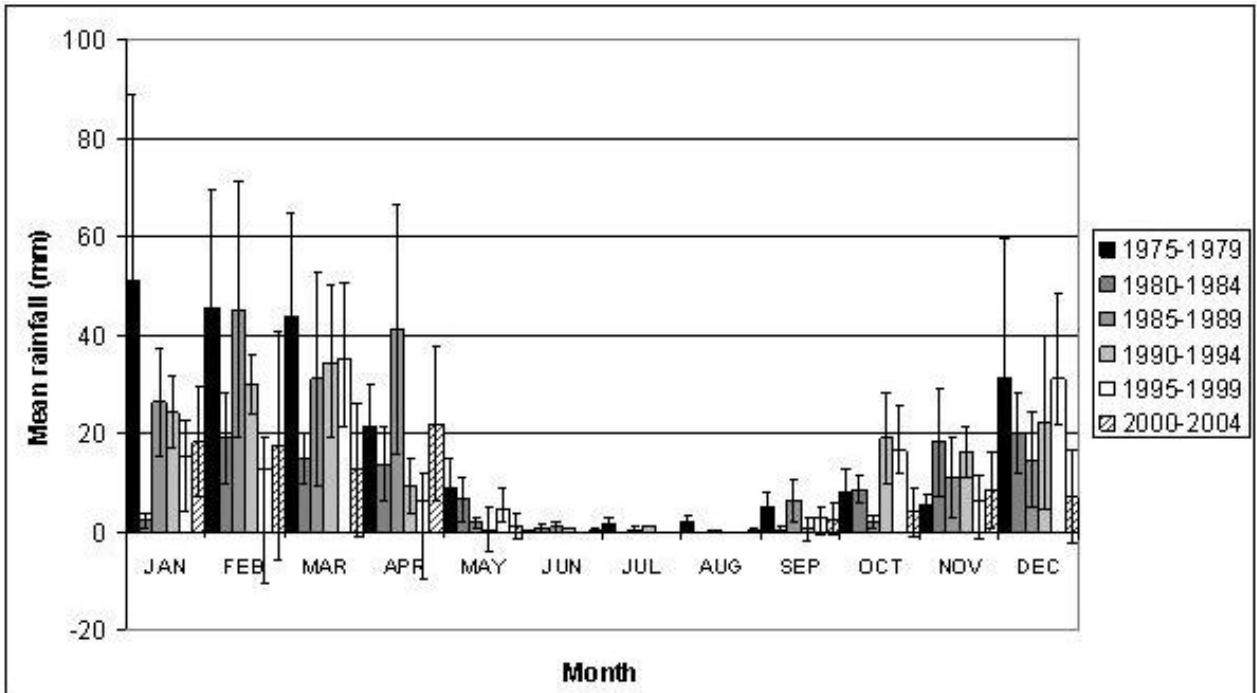
Fig. 3 . Monthly rainfall patterns for consecutive five-year periods in Bokspits (100 km southwest of Khawa), 1975–2004. (Data source: Department of Meteorological Services,